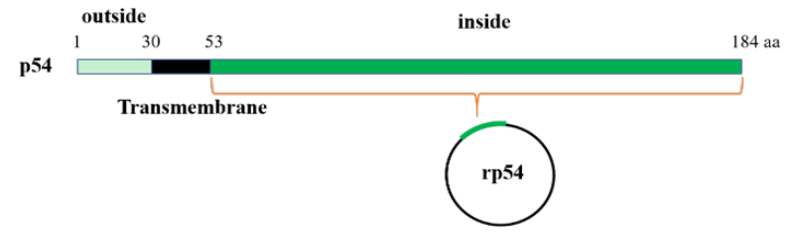
Figure 1. Strategy of the truncated recombinant p54 (rp54) expression.